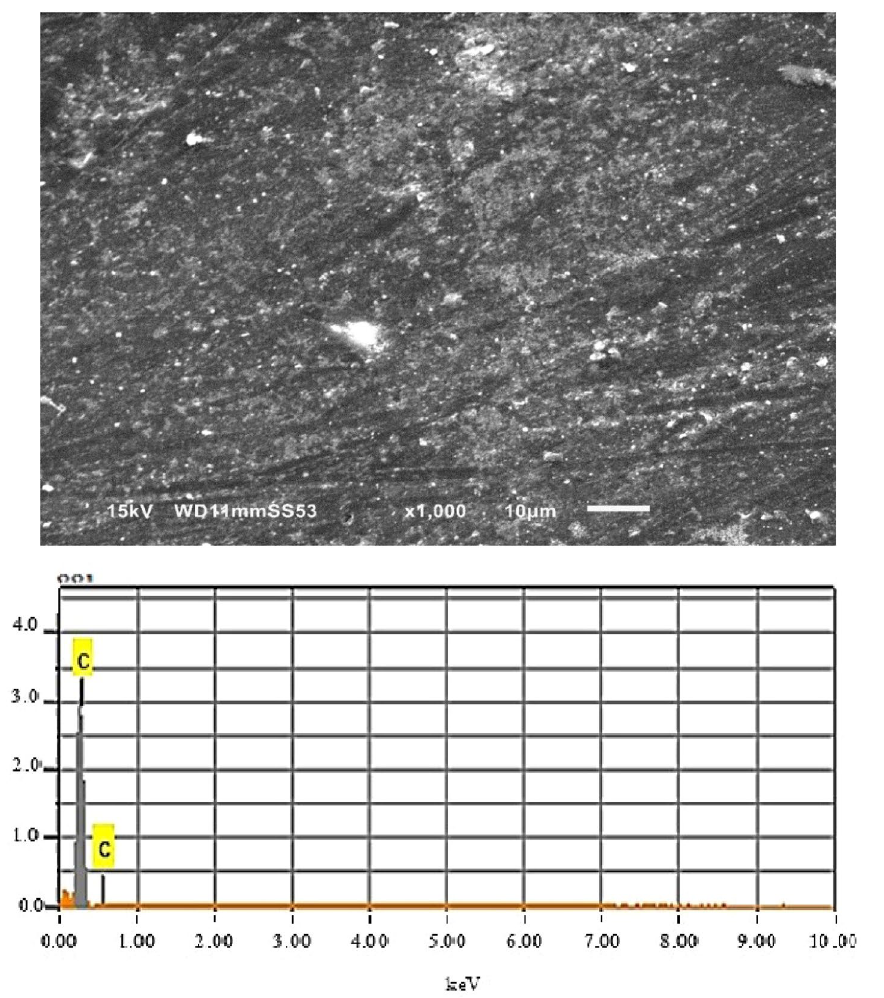
Figure 12. SEM analysis along with EDX of coated base metal zone.